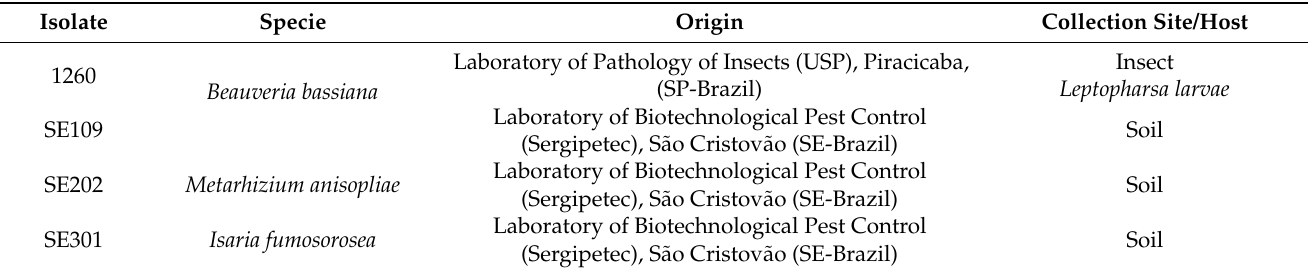
Table 1. Entomopathogenic fungi isolates used in this study.